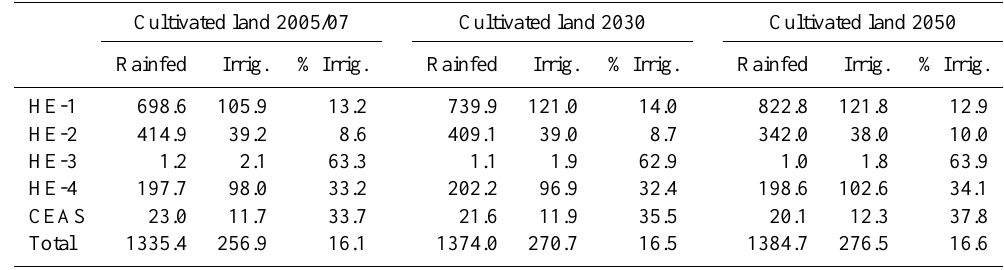
Table A18. Current and projected (actually) irrigated land (million ha).